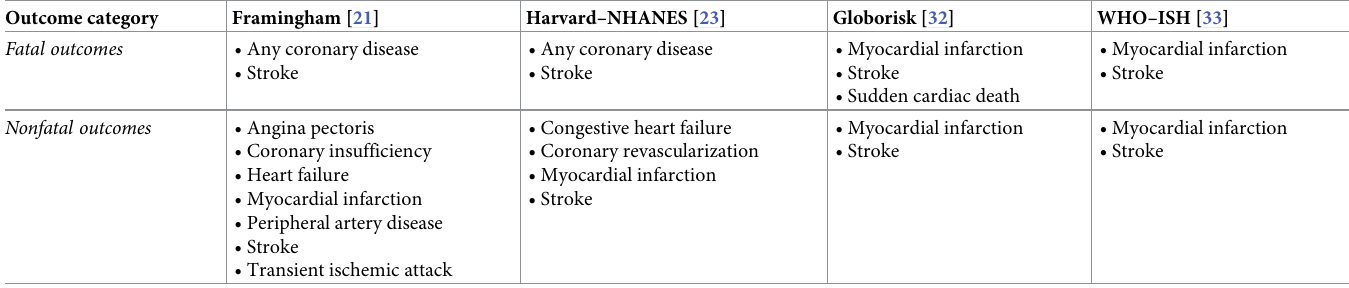
Table 1. Outcomes predicted by each cardiovascular risk